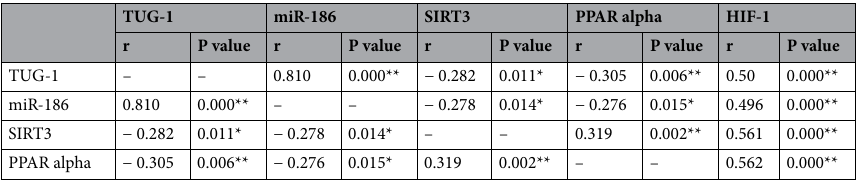
Table 4. Correlations between the different studied parameters. P value > 0.05: non significant; P value < 0.05: significant*; P value < 0.01: highly